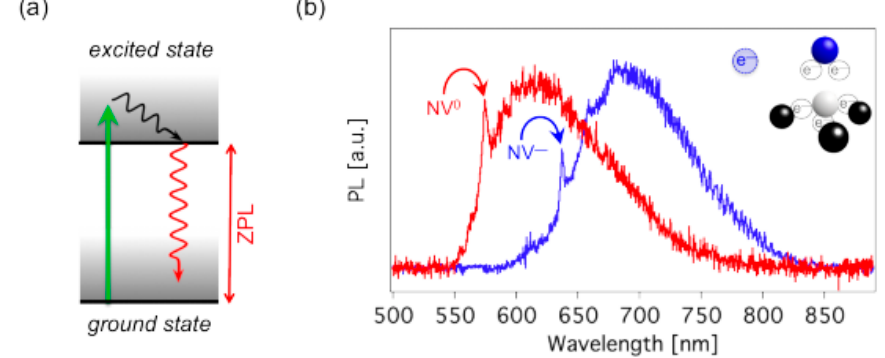
Figure 2. ( a ) Electronic band structure of an ‘atom-like’ NV center showing the ground state and excited state; ( b ) Normalized photoluminescence spectra of NV(0) (red) and NV( − ) (blue) color centers. The red and the blue spectra elucidate the two peaks associated with the zero phonon line at 575 nm (2.156 eV) and 637 nm (1.945 eV). The solid gray circles in the inset denote the available five electrons in the NV(0) center. The additional trapped electron in the NV( − ) center is represented by the dashed blue circle. The white, green and blue spheres denote an N atom, a C atom and a single vacancy site in the diamond lattice, respectively. Adapted from [23].